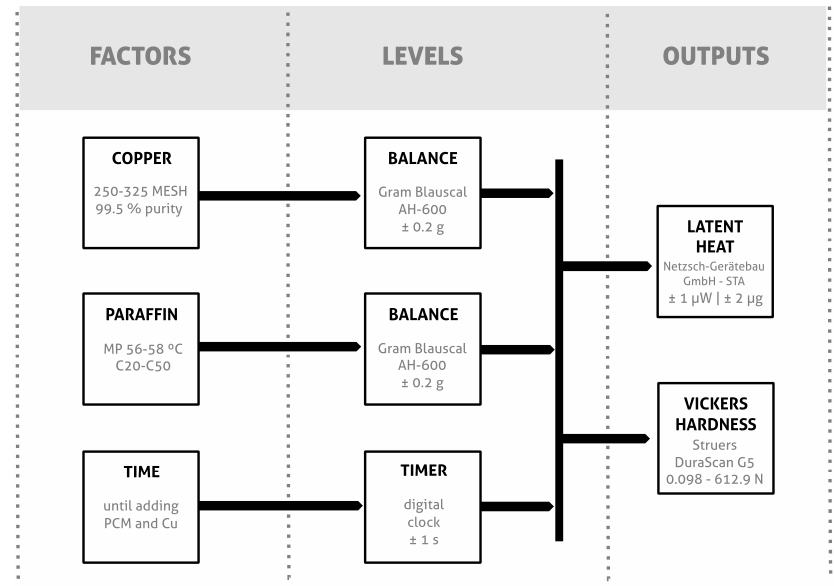
Figure 7. Schematic diagram of the variables analyzed and the methods used to characterize the samples.